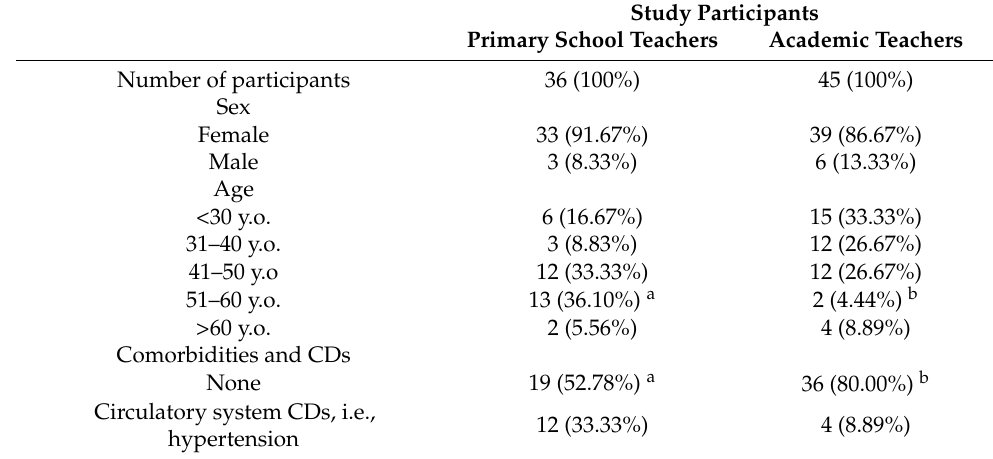
Table 1. Characteristics of the study